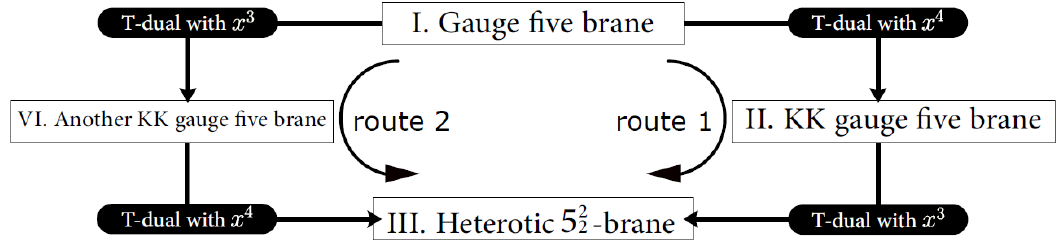
Figure 2 . The picture indicates the T-duality relations among heterotic (cid:12)ve-branes. Since the gauge (cid:12)ve brane has two isometry directions ( x 3 ; x 4 ), there are two routes to obtain heterotic 5 2 2